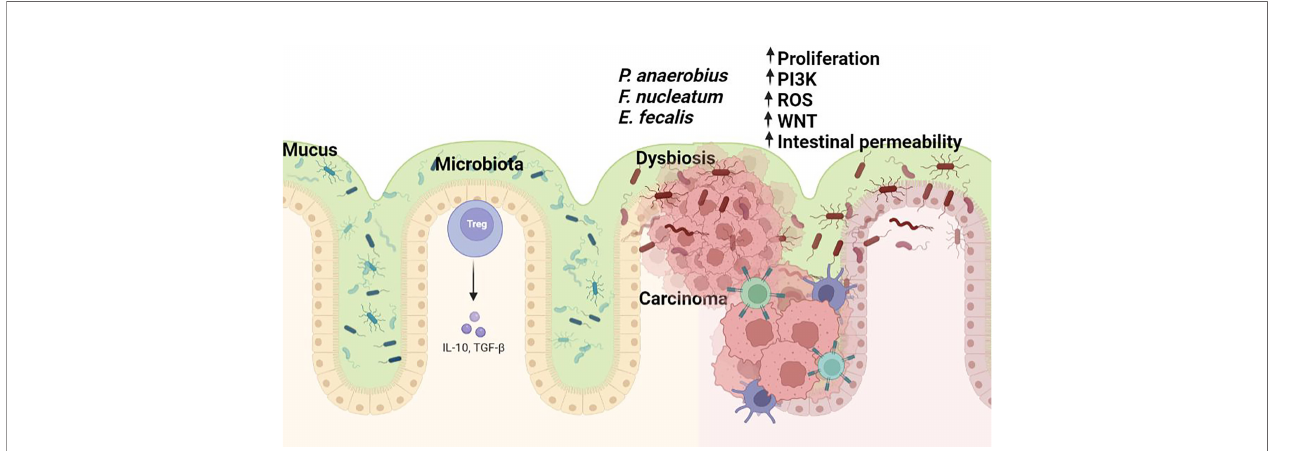
FIGURE 1 | The microbiome in colorectal carcinogenesis. Several bacterial taxa including Fusobacterium sp., Enterococcus sp., and P.anaerobius are commonly associated with colorectal cancer. Dysbiosis hinders the gut barrier function of epithelial tight junctions and the mucus layer favouring exposure of the intestinal epithelium to bacteria and their metabolites (some of which may harbour carcinogenic potential). Bacterial translocation causes enhanced in fl ammation associated with the production of toxic chemicals or procarcinogen molecules such as reactive oxygen species (ROS) by in fl ammatory cells (i.e., macrophages). All these changes lead to oxidative and subsequent DNA damage. Figure created in